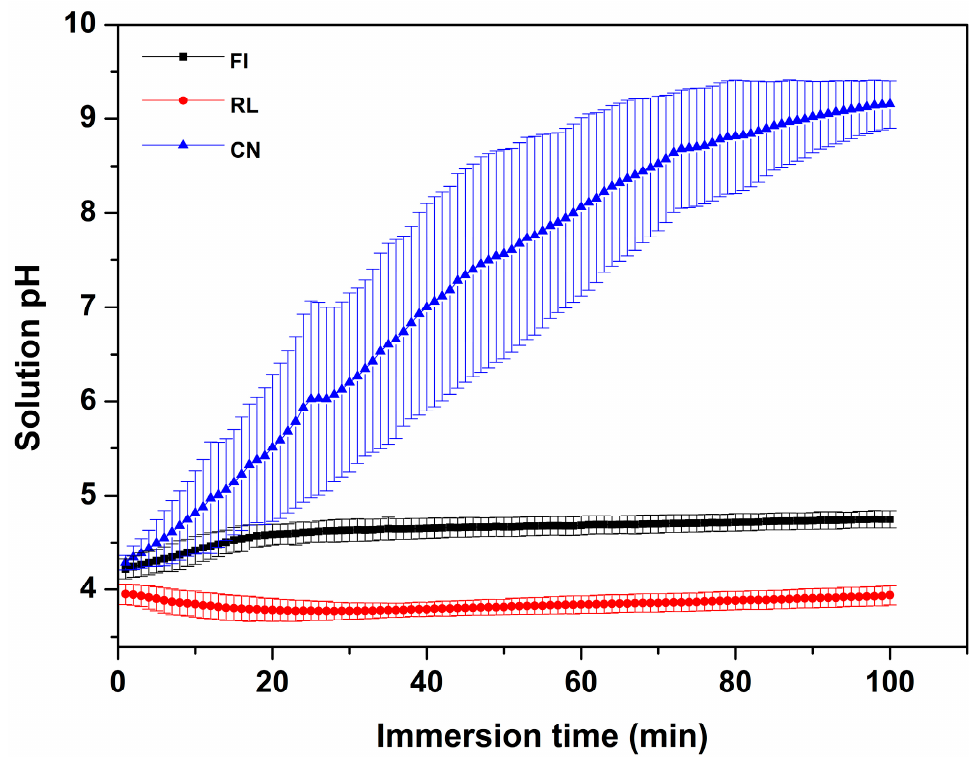
Figure 2 . pH change in lactic acid solution with each experimental material. Each value indicates the mean of 5 repeated measurements, and the error bars represent the deviation of the mean values (mean ± standard deviation; n = 5).